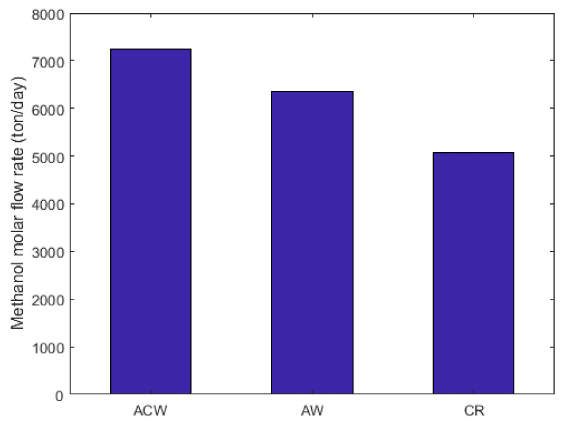
Figure 10. Methanol molar flow rate comparison between CR, AW, and ACW